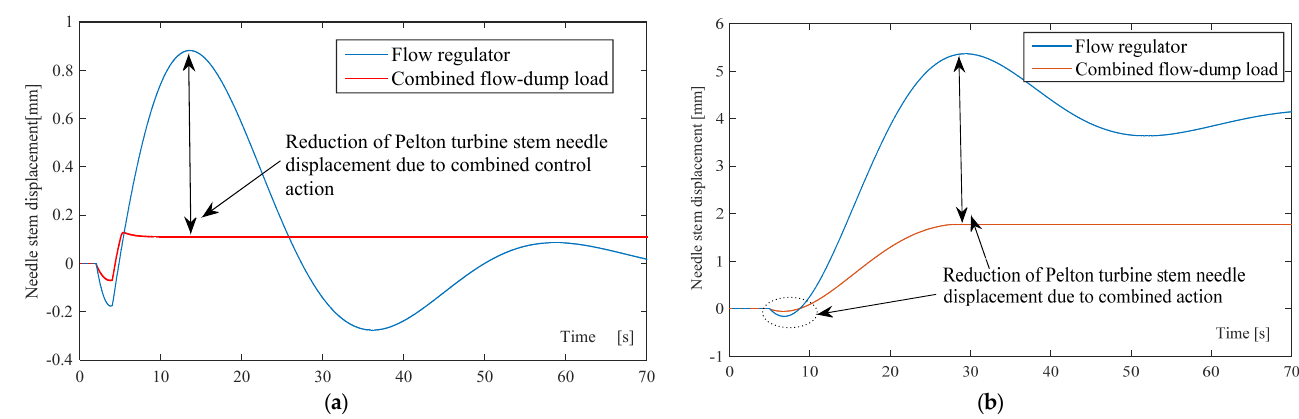
Figure 8. ( a ). Offset of the Pelton turbine stem nozzle for impulse loads of 10%. ( b ). Offset of the Pelton turbine stem nozzle for sustained loads of 10%.